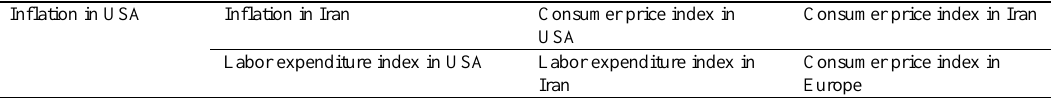
Table 4. The factors used as annually in the model.